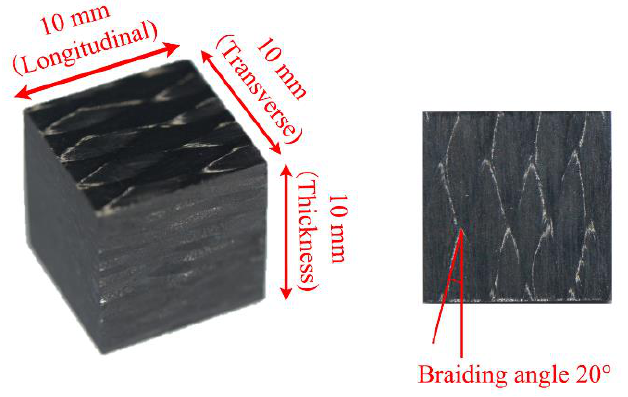
Figure 3. Specimen of 3D four-step braided composite for SHPB